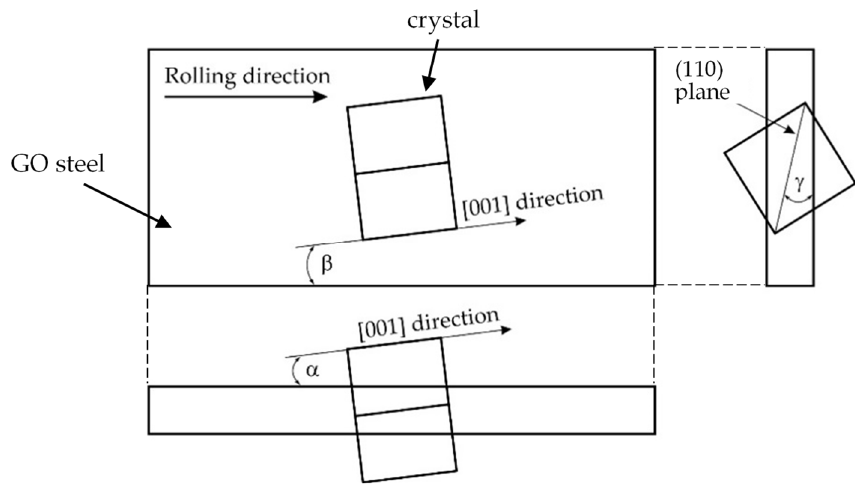
Figure 1. A schematic representation of a single crystal misorientation angles in relation to the ideal Goss texture presented in three orthogonal planes. Table 2. Values of misorientation angles in relation to ideal Goss orientation. EBSD.